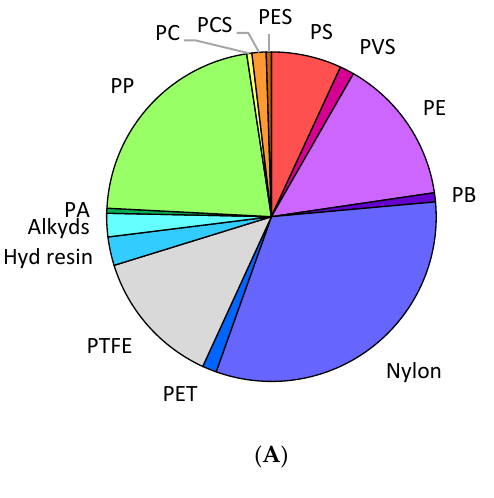
Figure 4. ( A ). MP polymer types detected at sampling site 1 (A63) throughout the 13 ‐ month Figure 4. ( A ) MP polymer types detected at sampling site 1 (A63) throughout the 13-month sampling sampling period, and ( B ). MP polymer types detected in the combined control samples. period, and ( B ) MP polymer types detected in the combined control samples. Abbreviations: alkyds, mixed alkyd resins; hyd resin, hydrocarbon resins; PA, poly (acetal); PB, poly(butadiene); PC, poly- carbonate; PCS, Poly(4-chlorostyrene:styrene); PE, polyethylene; PAS, poly (acrylate:styrene); PES, polyester; PET, polyethylene terephthalate; PP, polypropylene; PS, polystyrene; PTFE, polytetrafluo- roethylene, PVAE, poly (vinyl